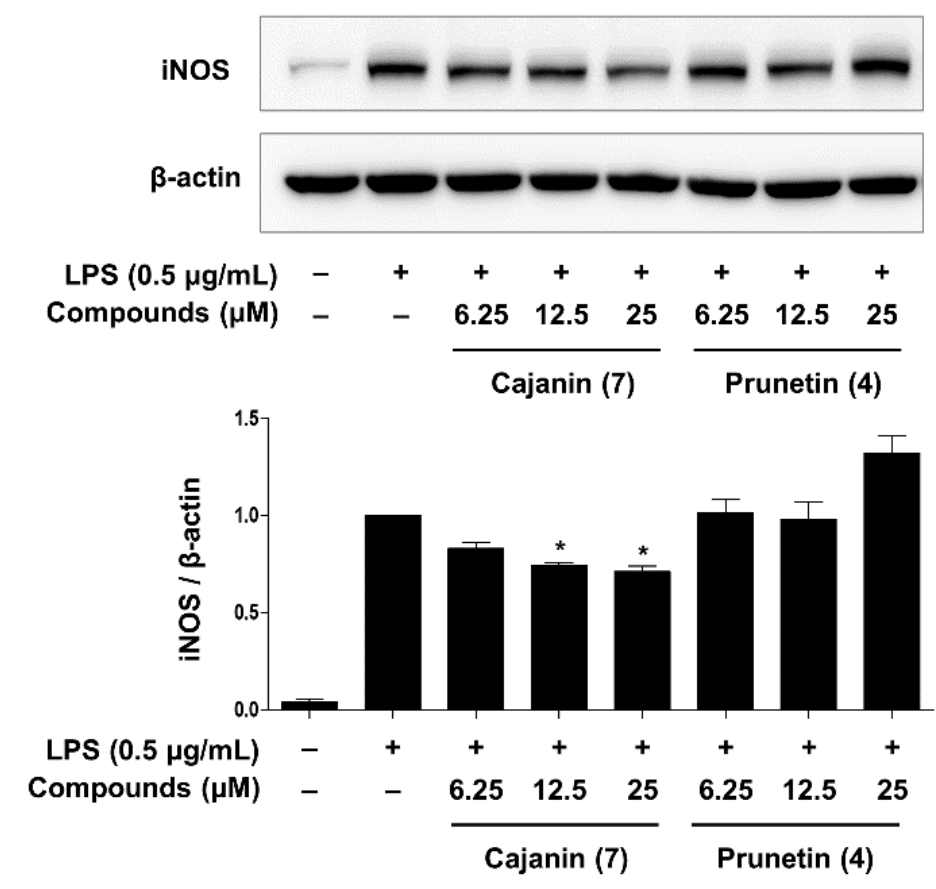
Figure 4. Effects of prunetin ( 4 ) and cajanin ( 7 ) on LPS-activated iNOS protein expression in macrophages. Western blot analysis was performed to measure iNOS protein levels normalized to that of β -actin as the loading control. The ratio of the iNOS/ β -actin band intensities was calculated using the ImageJ program. The results are shown as the mean ± SEM of three independent experiments. Asterisks indicate a significant difference compared to the LPS alone group (* p < 0.05). The inflammatory molecules iNOS, NO, TNF- α , and IL-6 are regulated by the tran- scription factor NF- κ B, a key mediator of inflammatory responses [31]. To examine whether the activity of NF- κ B was suppressed by cajanin ( 7 ) and prunetin ( 4 ), the phosphorylation of I κ B (p-I κ B) and p-p65 in whole-cell lysates was measured by Western blot analysis. As shown in Figure 5A, compared to prunetin ( 4 ), cajanin ( 7 ) markedly inhibited the expres- sion of p-I κ B and p-p65 at 12.5 and 25 µ M compared to the group treated with LPS alone. In addition, an immunofluorescence analysis was performed to investigate the blockade effect of nuclear transcription factor (NF- κ B) affected by cajanin ( 7 ) and prunetin ( 4 ). As shown in Figure 5B, cajanin ( 7 ) dramatically diminished the translocation of NF- κ B (p65) to the nucleus at 25 µ M, whereas prunetin ( 4 ) failed to completely block the translocation of NF- κ B (p65) to the nucleus at this same concentration (Figure S18). These results suggested that the inhibitory effects of cajanin ( 7 ) on LPS-induced inflammatory mediators, such as NO, IL-6, TNF- α , and iNOS, were attributed to the blockade of NF- κ B transcription factor activity via the suppression of p-p65 and p-I κ